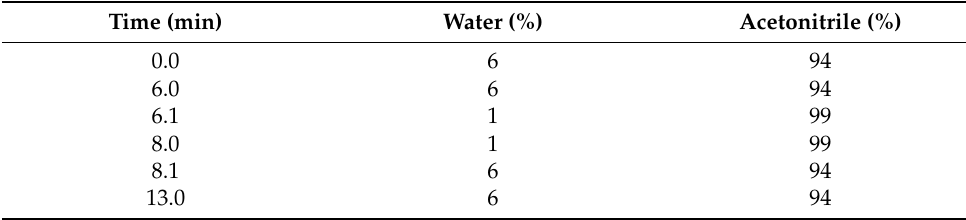
Table 1. Gradient elution program for AVMS